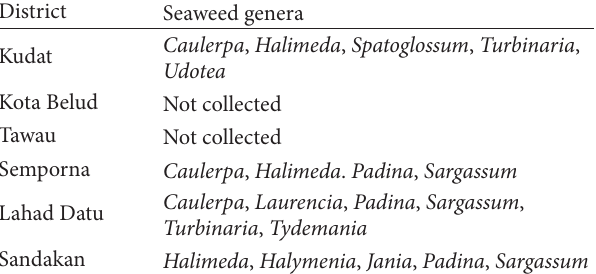
Table 8: List of main seaweeds genera available at each district.